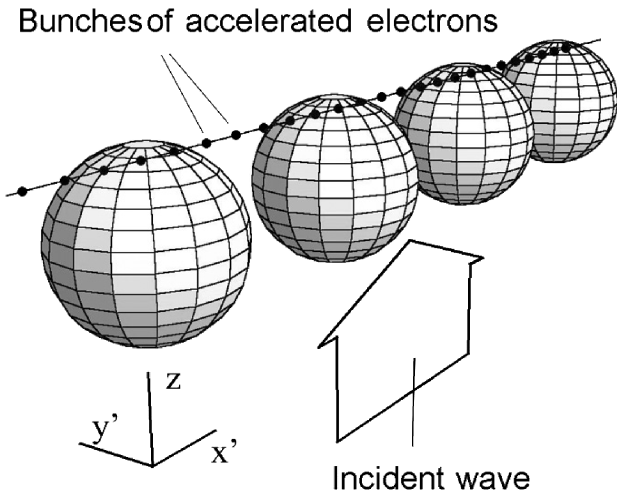
FIG. 10. An example of accelerating electron bunches passing synchronously above a periodic chain of scattering spheres. The bunches are separated by (cid:8) and the distances between the spheres are D (cid:2) 6 (cid:8) . The x 0 axis is parallel to the electron velocity ~ (cid:9) .